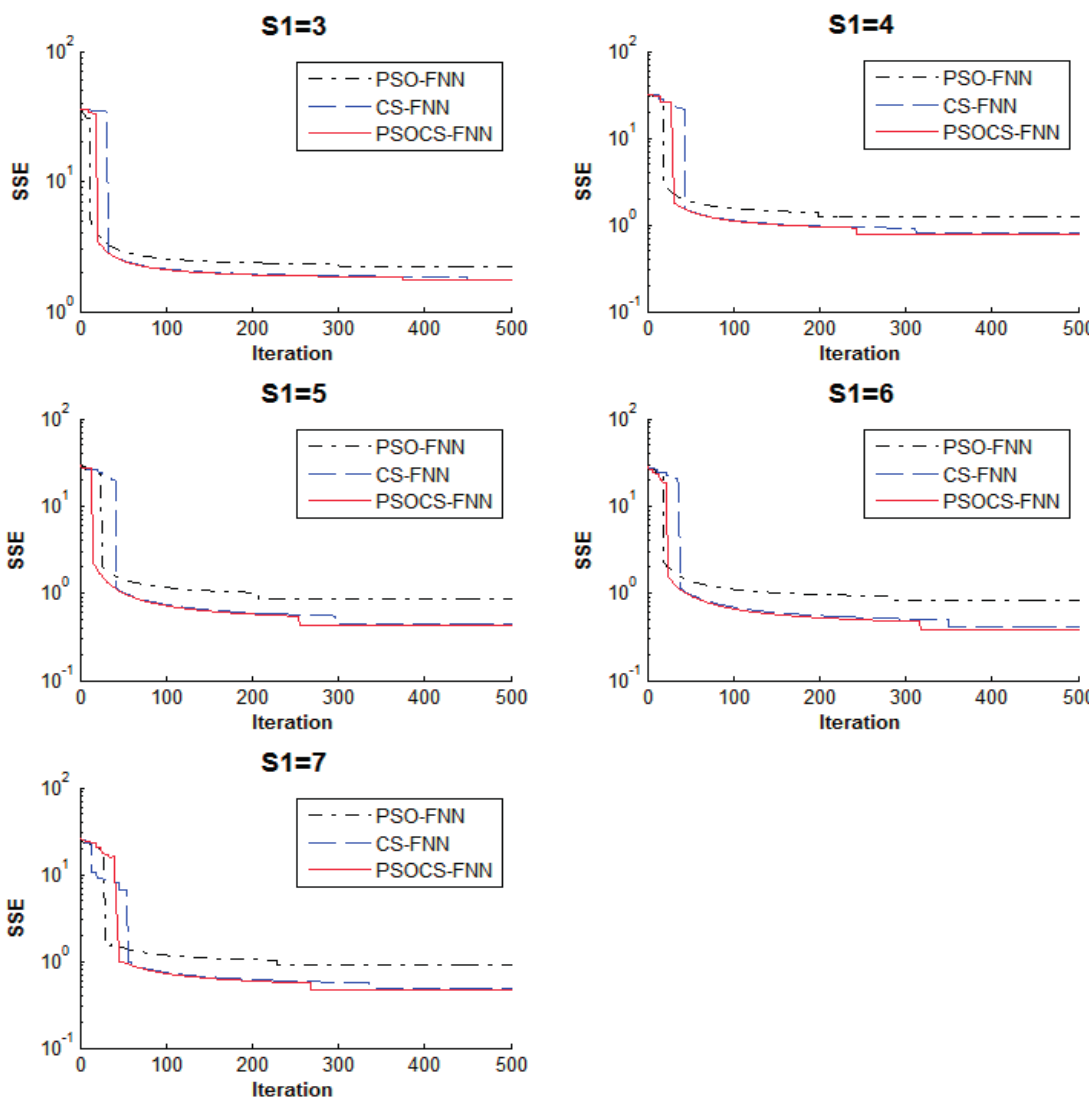
Figure 4. Convergence of PSO-FNN, CS-FNN, and PSOCS-FNN in the function approximation with S 1 = 3, 4, 5, 6, and